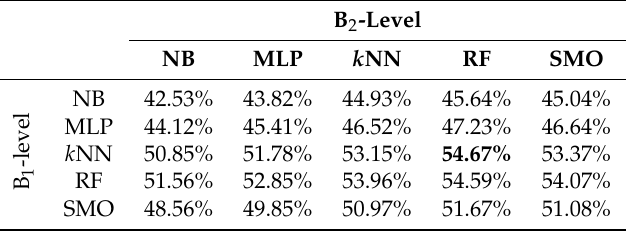
Table 4. Two-level classifier classification using MLP as A-level